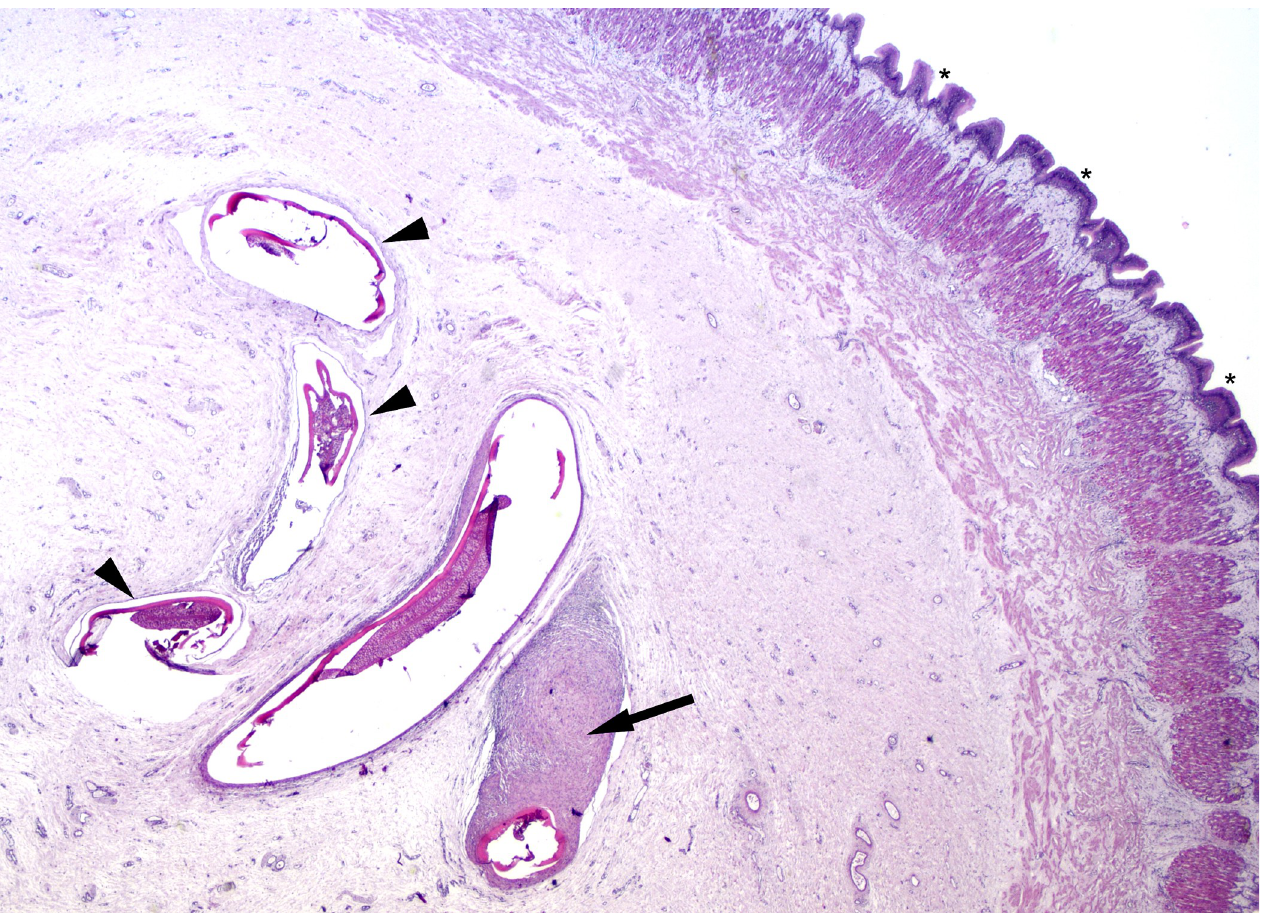
Fig 2. Cross section of a shortspine thornyhead ( Sebastolobus alaskanus ) stomach with multiple nematodes in the stomach submucosa. Asterisks are placed along the surface of the stomach mucosa. Nematodes are surrounded by negligible (arrow heads) to intense (arrow) granulomatous inflammation, which is the typical host response to parasites in fish. Magnified 40x; stained with hematoxylin and counterstained with eosin.